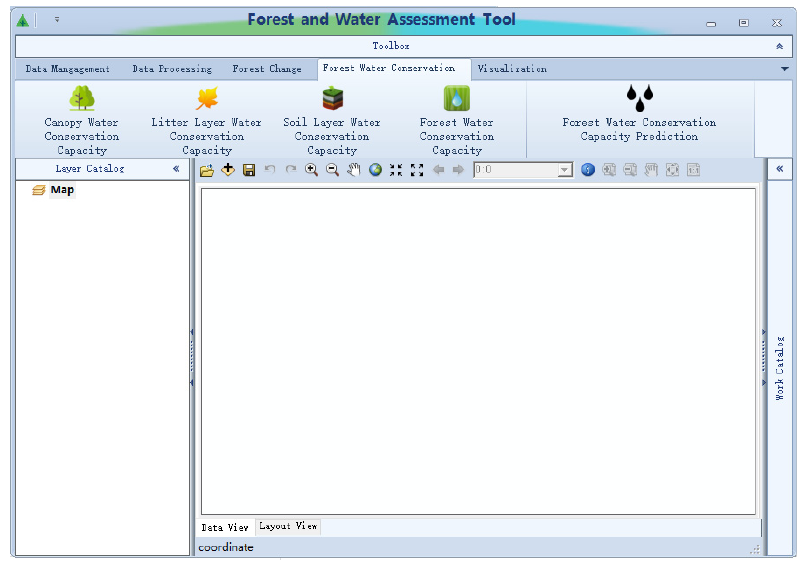
Figure A1. FWAT main interface.